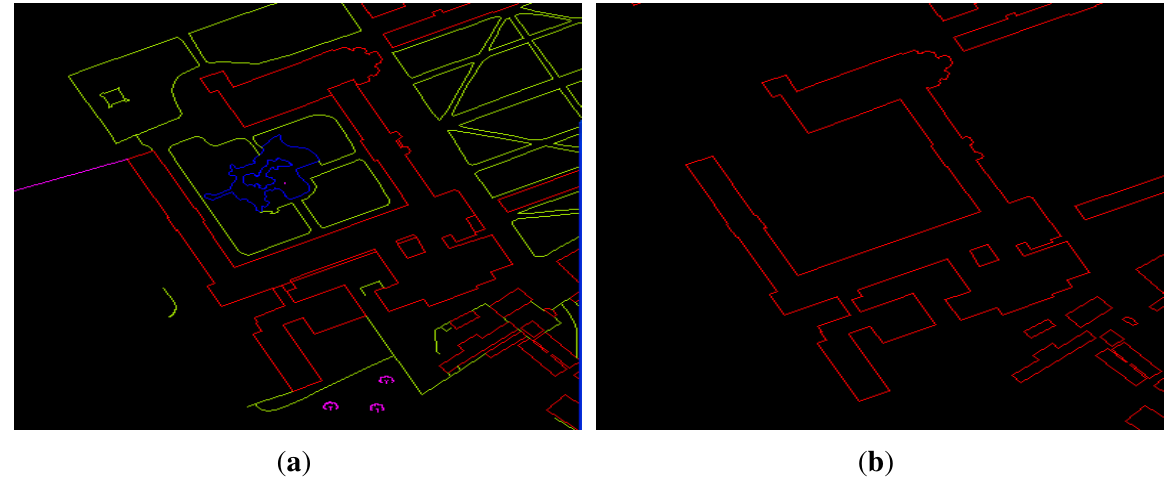
Figure 4. Ordnance Survey Ireland 2D vector mapping ( a ) all layers active in the test area viewed in a CAD environment ( b ) building footprint layer isolated for obstruction